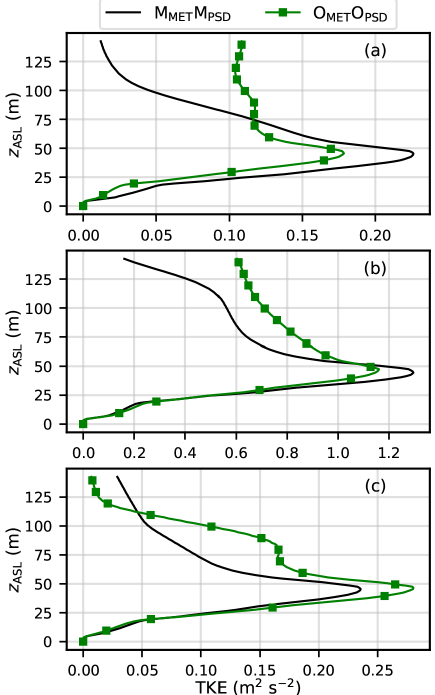
Figure 5. The vertical profile of the mean turbulent kinetic energy (TKE) over the entire child domain for the (a) summer morning, (b) summer evening and (c) winter morning simulation. Each profile is temporally averaged over the whole